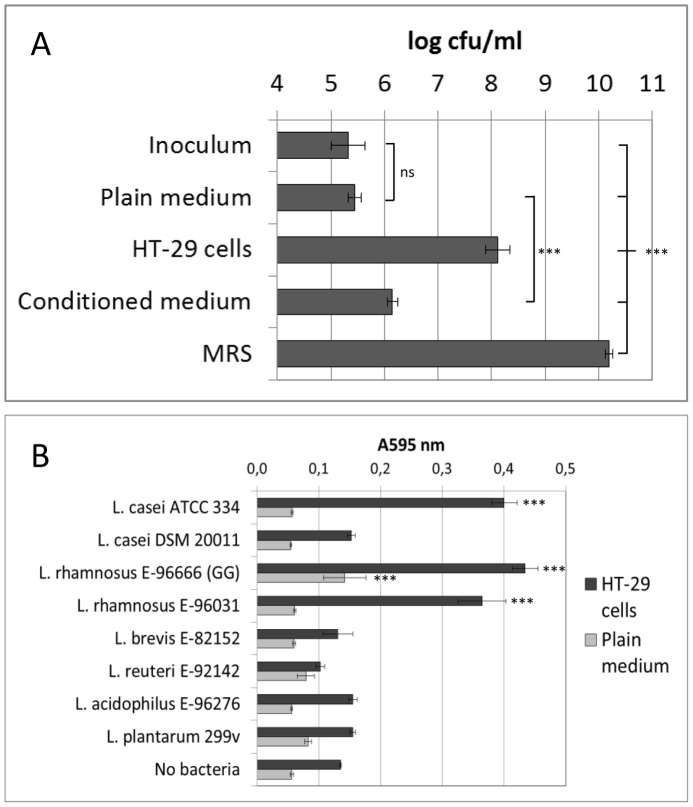
Effect of HT-29 intestinal epithelial cells on growth of Lactobacillus strains.A. Lactobacillus casei ATCC 334 was cultivated in MRS broth overnight, and then inoculated into McCoy’s 5A medium (plain medium), onto HT-29 cells in McCoy’s 5A medium (HT-29 cells), or into McCoy’s 5A medium that had been collected from HT-29 cells after 18 hour incubation (conditioned medium). Bacteria were also inoculated into MRS broth. After 18 hour cultivation, numbers of bacteria were determined by viable counting. Averages of three (conditioned medium), four (plain medium and MRS) or eight (HT-29 cells) replicate samples and standard deviations are shown. cfu = colony forming unit. ***, p<0.001; ns, non-significant (one-way Anova followed by Tukey’s Multiple Comparison test). B. Lactobacillus strains were inoculated onto HT-29 cells or into plain medium in 96-well plates. Bacterial growth was measured by absorbance at 595 nm. Averages of four replicate samples and standard deviations are shown. ***, samples differing from the corresponding non-bacteria control, p<0.001 (one-way Anova followed by Tukey’s Multiple Comparison test).